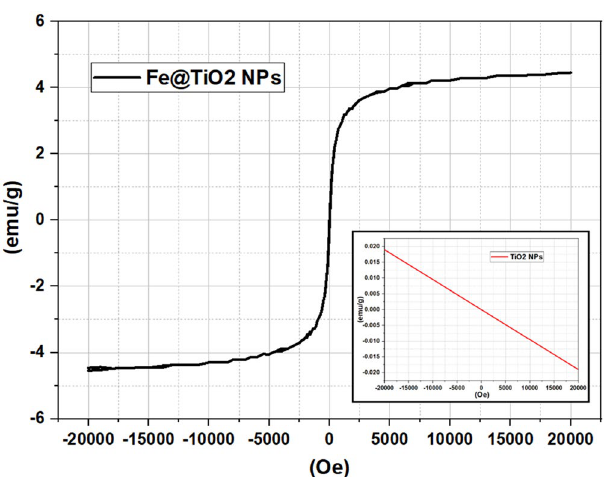
Figure 5. The VSM plot of Fe@TiO 2 NPs depicts superparamagnetic behavior. The inset displays the diamagnetic character of pure anatase TiO 2 NPs.